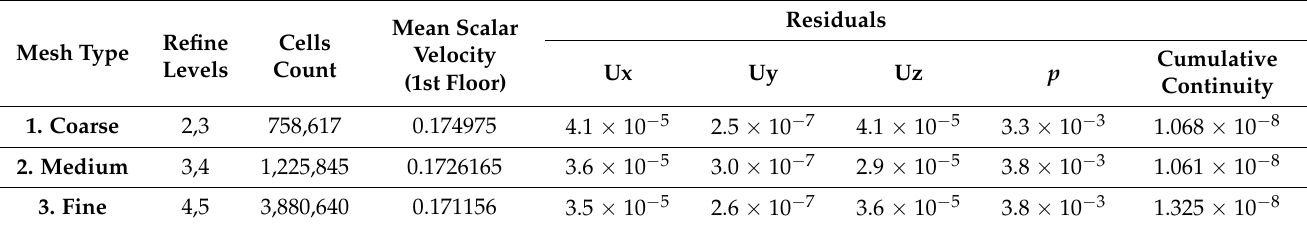
Table 2. Grid sensitivity with CFD